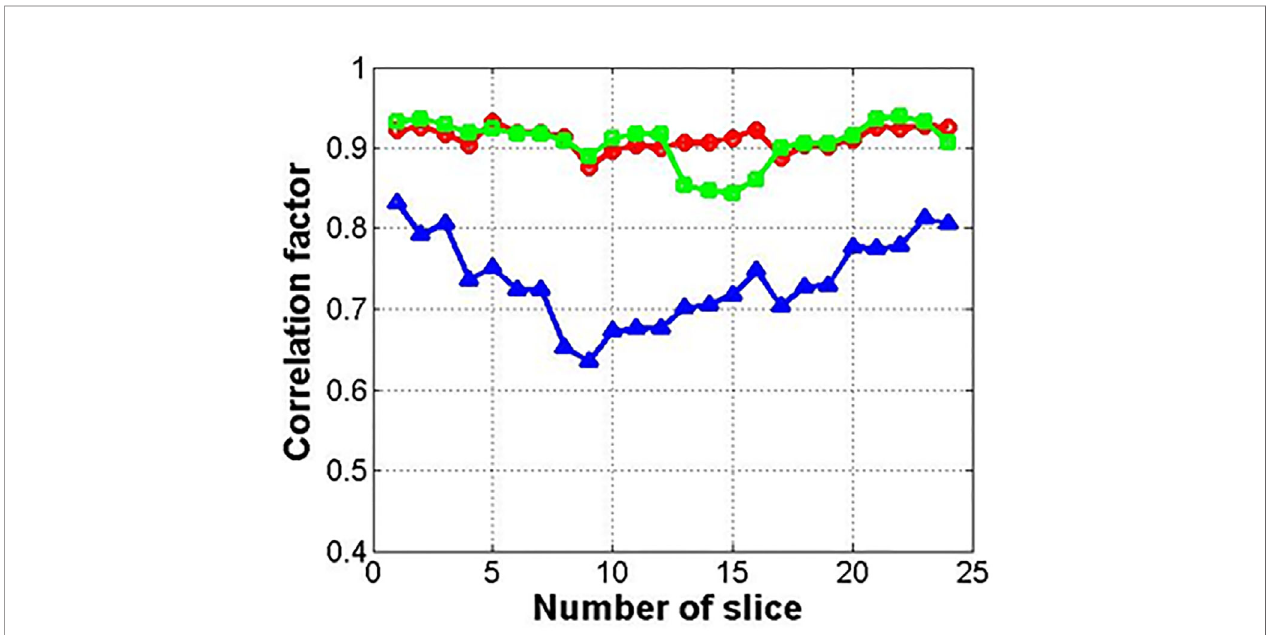
FIGURE 12 | Correlation factor between input and output images for GAN (circle, square, and triangle marks indicate methods 1, 2, and 3,